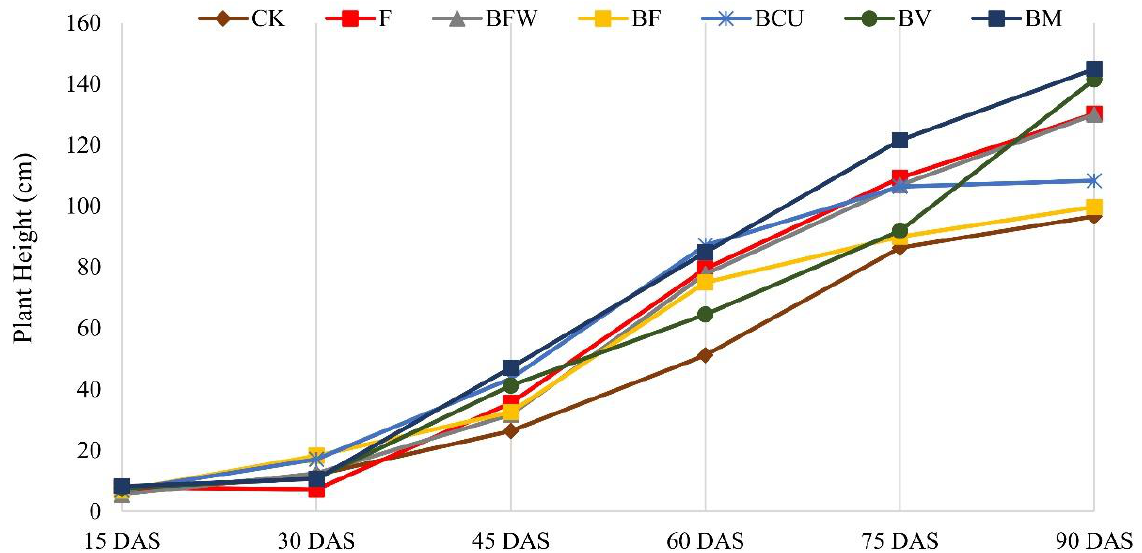
Figure 1. Effects of various biochar-blended or enriched organic and inorganic treatments on plant height recorded at every 15-day interval from 15 DAS to 90 DAS.